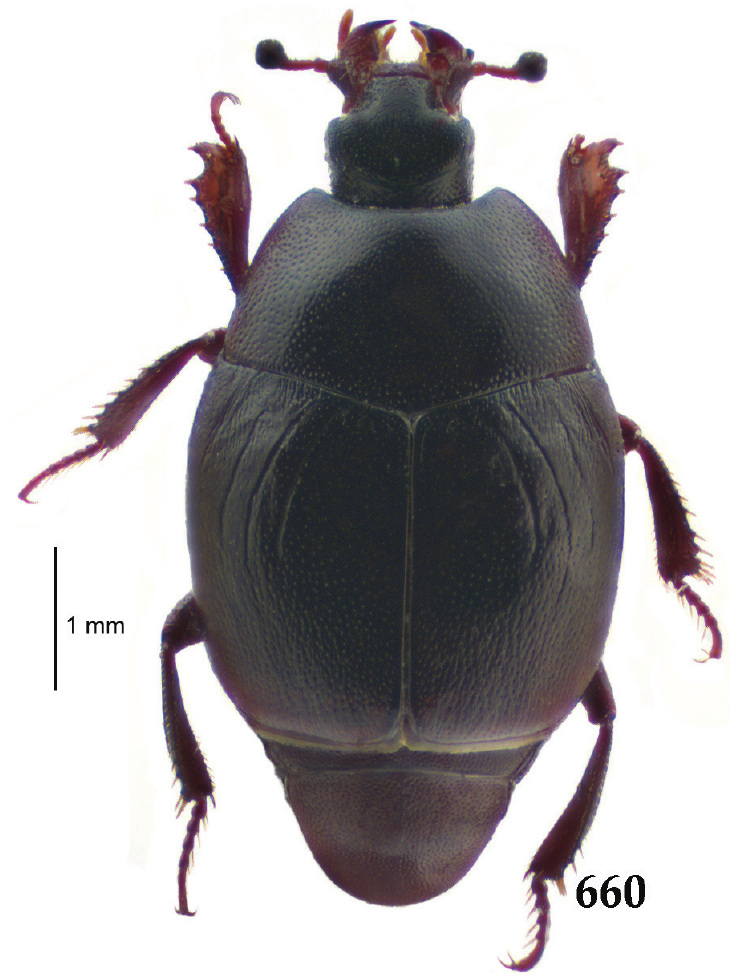
Figure 660. Tomogenius kuscheli Dahlgren, 1976 habitus, dorsal view. Re-description. Body length: PEL: 4.00–4.40 mm; EL: 2.25–2.75 mm; APW: 1.25–1.50 mm; PPW: 2.75–3.00 mm; EW: 3.25–3.50